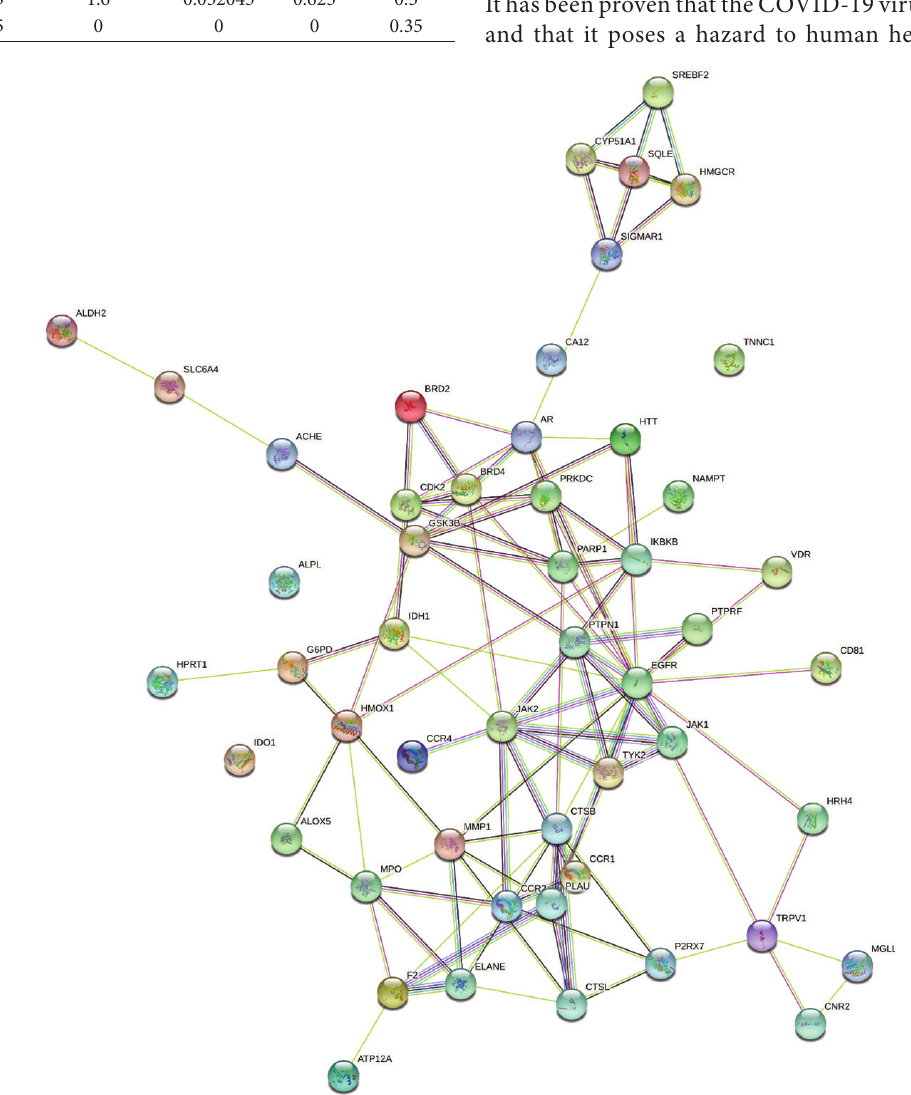
Figure 2. Protein-protein interaction (PPI) and hub genes of CSL against